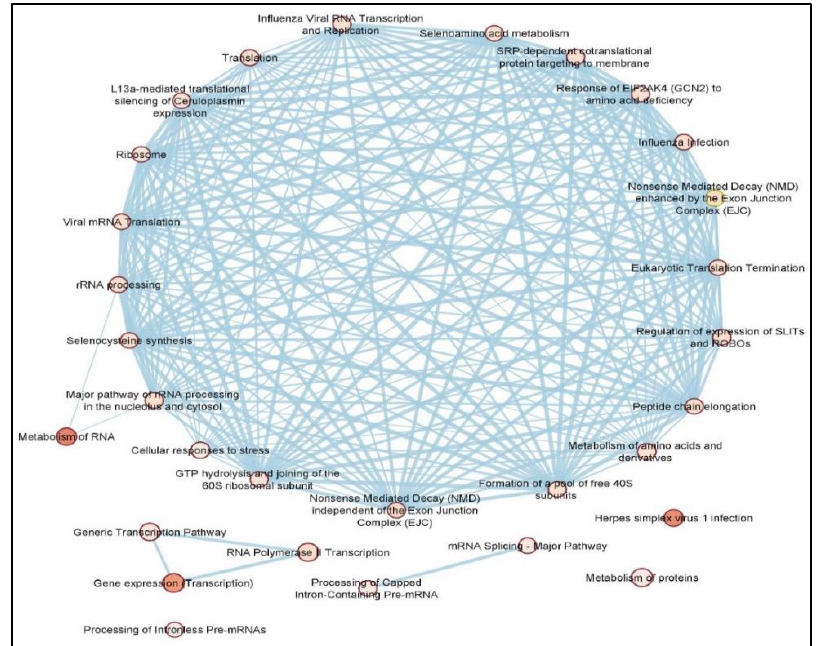
Figure 3. Enrichment map of KEGG (dark pink nodes) and Reactome (light pink nodes) pathways of DEPCGs as indicated by STRING enrichment in Cytoscape. The thickness of a line indicates the strength of the interaction between the proteins it connects.